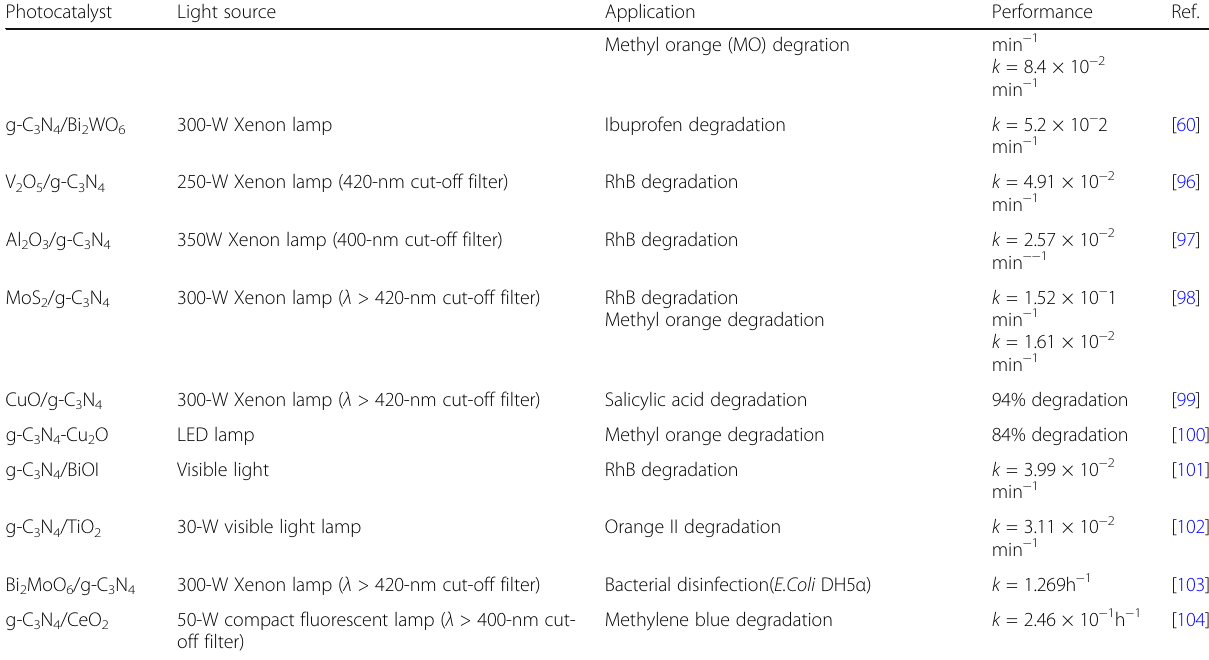
Table 1 Studies of g-C 3 N 4 heterojunctions for various pollutants degradations (Continued)